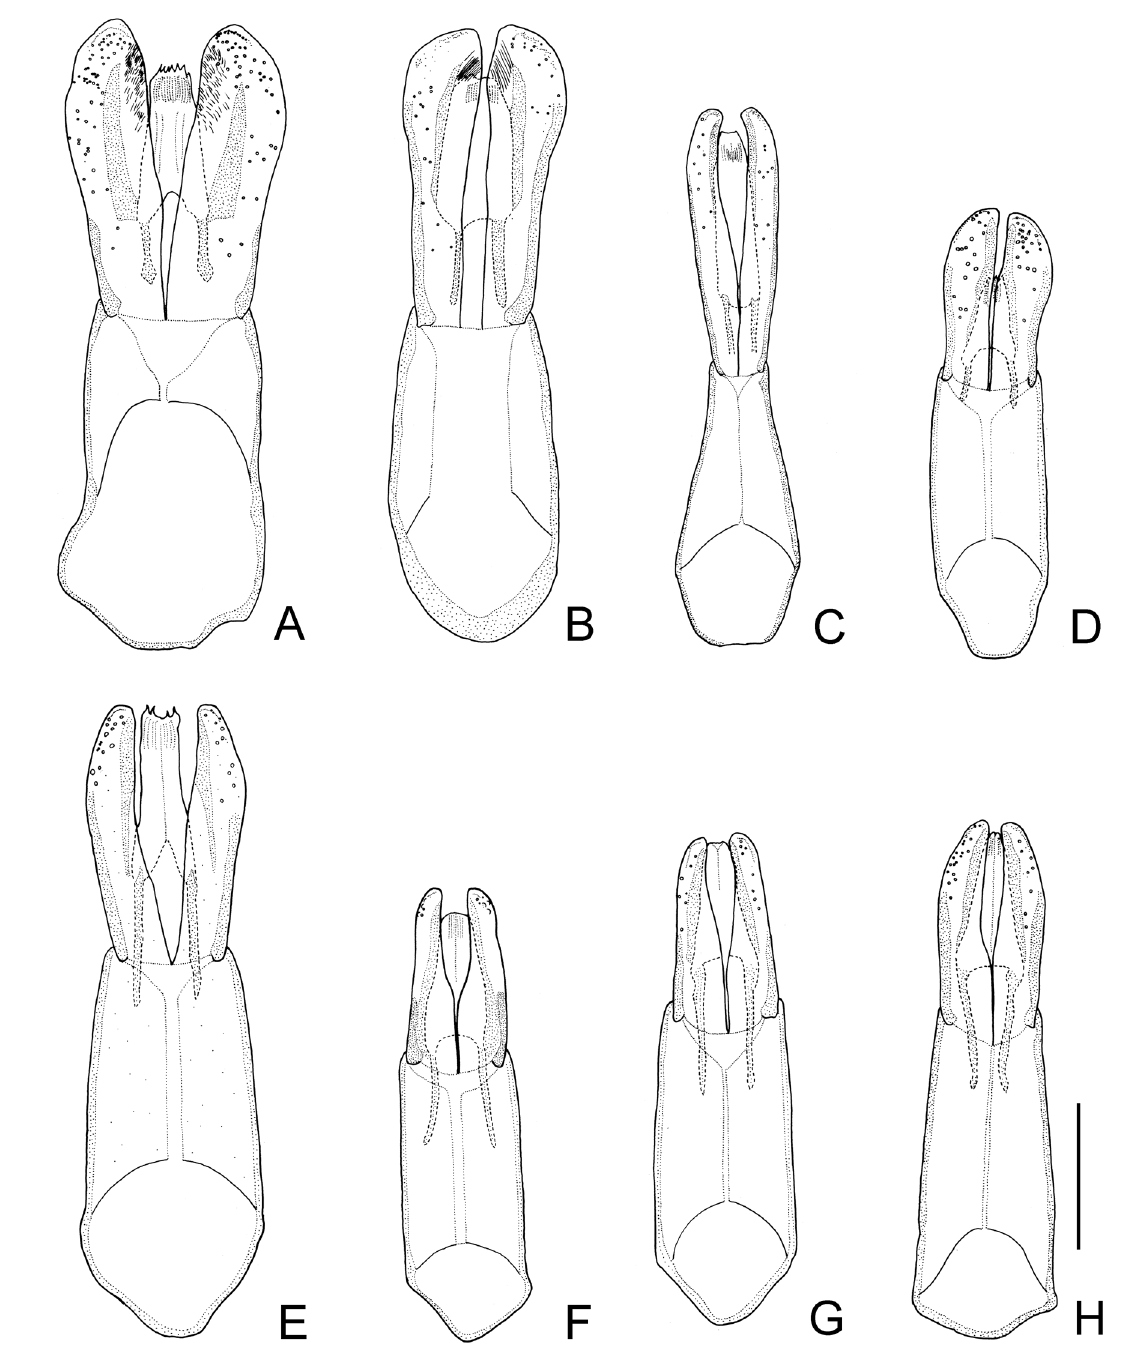
Fig. 9. Male aedeagus of Georissus spp. A . G . ( G .) canalifer Sharp, 1888. B . G . ( G .) babai Satô, 1970. C . G . ( Ni .) granulosus Satô, 1972. D . G . ( Ne .) japonicus Satô, 1972. E . G . ( Ne .) kurosawai Nakane, 1963. F–G . G . ( Ne .) takahashii sp. nov. from Kochi (F) and Okinawa (G). H . G . ( Ne .) satoi sp. nov. Scale bar = 0.1